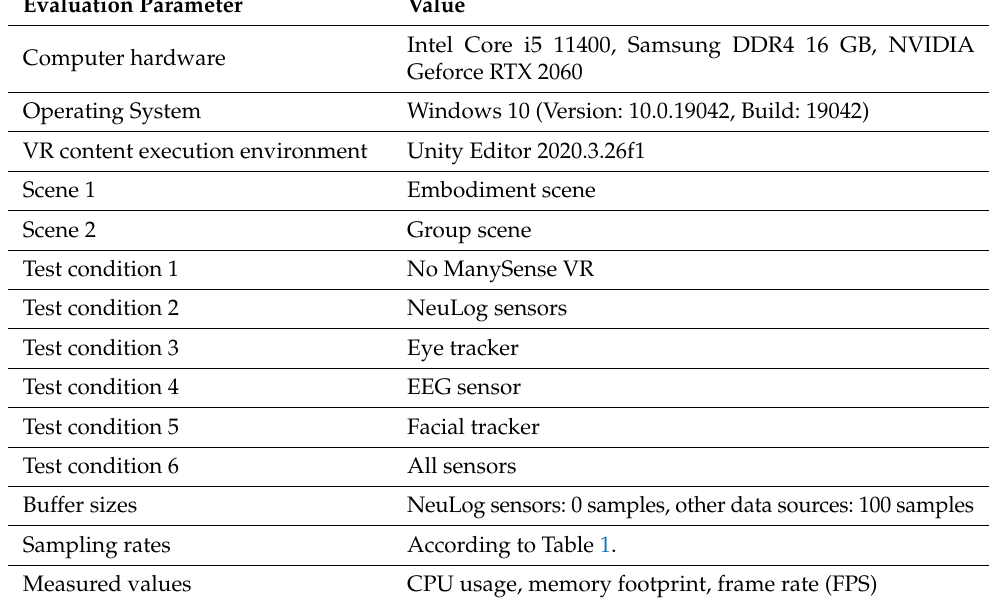
Table 2. Evaluation